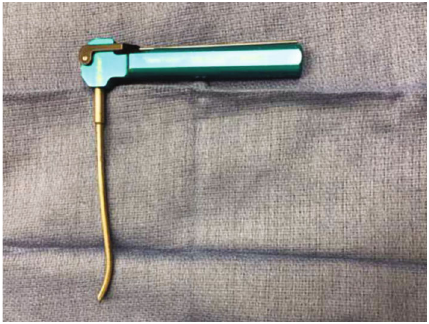
Figure 2: Curved endoscopic femoral drill guide (Stryker, Kalamazoo,